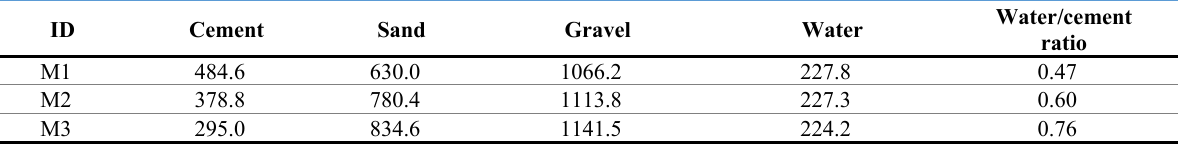
Table 2 – Compositions of concrete (kg/m 3